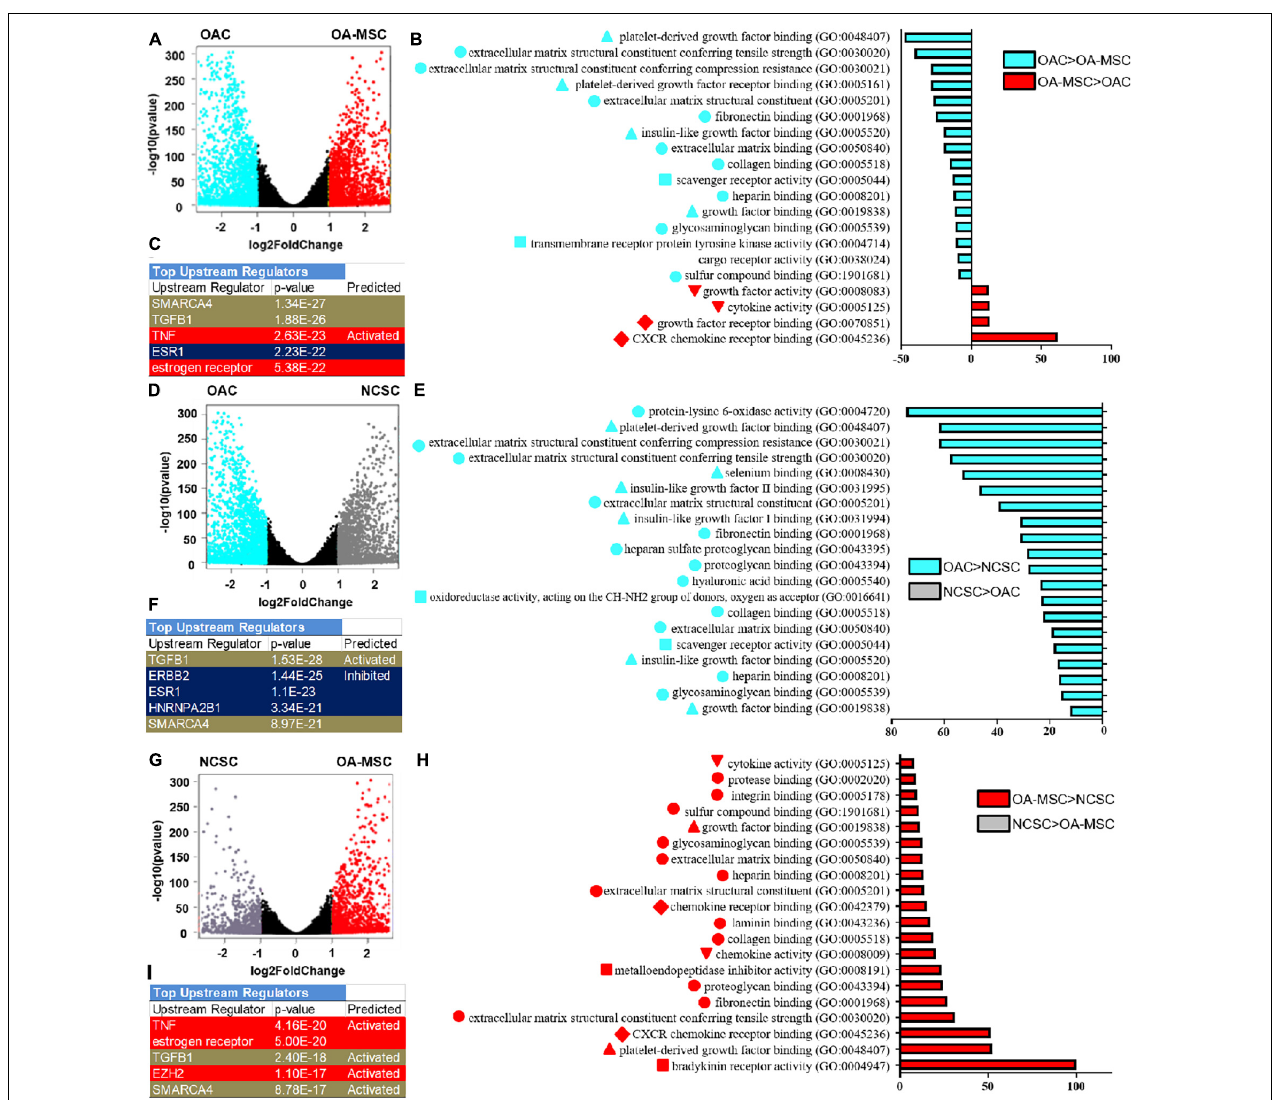
FIGURE 4 | RNA sequencing bioinformatics analysis of OAC vs. OA-MSC (A–C) , OAC vs. NCSC (D–F) , and NCSC vs. OA-MSC (G–I) using volcano plot (A,D,G) , Gene Ontology (GO) (B,E,H) , and Ingenuity Pathway Analysis (C,F,I) . (A) Volcano plots analysis using RNAseq data of OAC and OA-MSC2 samples ( n = 3). The points in aquamarine color means higher expressed genes in OAC while the points in red color means higher expressed genes in OA-MSC (fold change > 2, p -value < 0.05). Each point represents one gene. (B) GO classification of top twenty groups of genes based on RNAseq of OAC and OA-MSC2 samples ( n = 3). Sixteen groups of genes (aquamarine color bars) were up-regulated in OAC. Classification with triangle: ECM regulatory function; classification with circle: ECM structural function; classification with square: cell receptor signaling; four groups of genes were up-regulated in OA-MSC (red color bars). Classification with inverted triangle: cytokine and growth factor activity; classification with diamond: chemokine and growth factor receptor binding. (C) IPA analysis of top upstream regulators based on RNAseq of OAC and OA-MSC2 samples ( n = 3). Brown color indicates common regulators between OAC vs. NCSC and NCSC vs. OA-MSC. Red color indicates unique regulators of NCSC vs. OA-MSC. Blue color indicates unique regulators of OAC vs. NCSC. p -Values and predicted effects when known are indicated. (D) Volcano plots analysis using RNAseq data of OAC and NCSC3 samples ( n = 3). The points in aquamarine color means higher expressed genes in OAC while the points in gray color means higher expressed genes in NCSC (fold change > 2, p -value < 0.05). Each point represents one gene. (E) GO classification of top twenty groups of genes based on RNAseq of OAC and NCSC3 samples ( n = 3). All top up-regulated groups of genes were in OAC (aquamarine color bars). Classification with triangle: ECM regulatory function; classification with circle: ECM structural function; classification with square: cell receptor signaling. (F) IPA analysis of top upstream regulators based on RNAseq of OAC and NCSC3 samples ( n = 3). Brown color indicates common regulators between OAC vs. NCSC and NCSC vs. OA-MSC. Blue color indicates unique regulators of OAC vs. NCSC. p -Values and predicted effects when known are indicated. (G) Volcano plots analysis using RNAseq data of NCSC3 and OA-MSC2 samples ( n = 3). The points in gray color means higher expressed genes in NCSC and the points in red color means higher expressed genes in OA-MSC (fold change > 2, p -value < 0.05). Each point represents one gene. (H) GO classification of top 20 groups of genes based on RNAseq of NCSC3 and OA-MSC2 samples ( n = 3). All top up-regulated groups of genes were in OA-MSC (red bars). Classification with triangle: ECM regulatory function; classification with circle: ECM structural function; classification with square: cell receptor signaling; classification with inverted triangle: cytokine and growth factor activity; classification with diamond: chemokine and growth factor receptor binding. (I) IPA analysis of top upstream regulators based on RNAseq of NCSC3 and OA-MSC2 samples ( n = 3). Brown color indicates common regulators between OAC vs. NCSC and NCSC vs. OA-MSC. Red color indicates unique regulators of NCSC vs. OA-MSC. p -values and predicted effects when known are indicated.